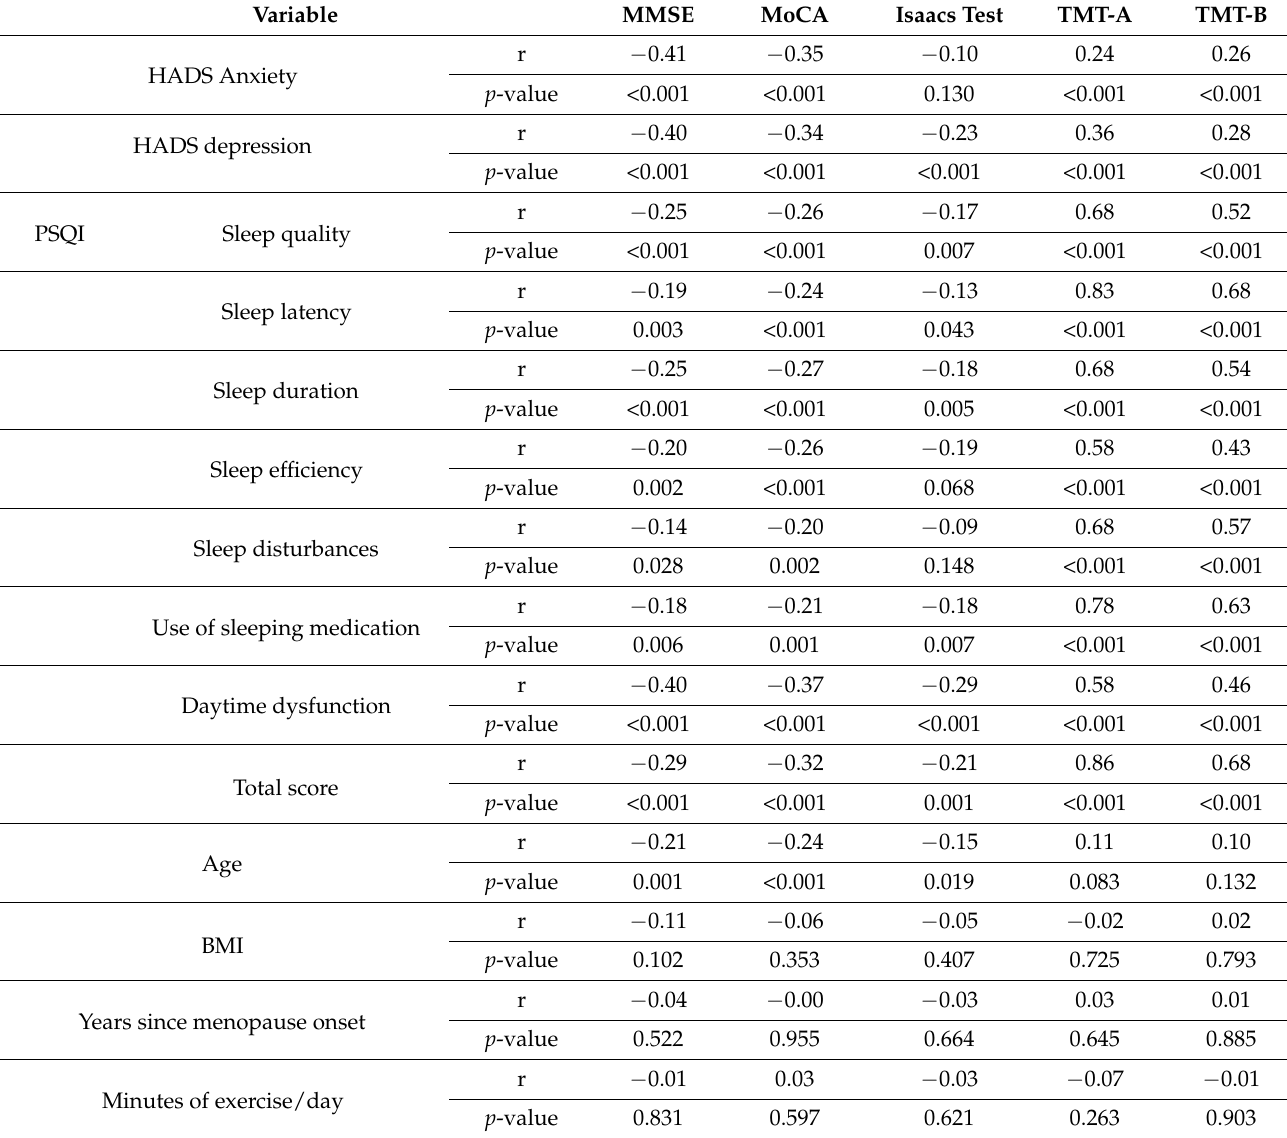
Table 2. Pearson’s correlations between cognitive outcomes and anxiety, depression, sleep quality and possible